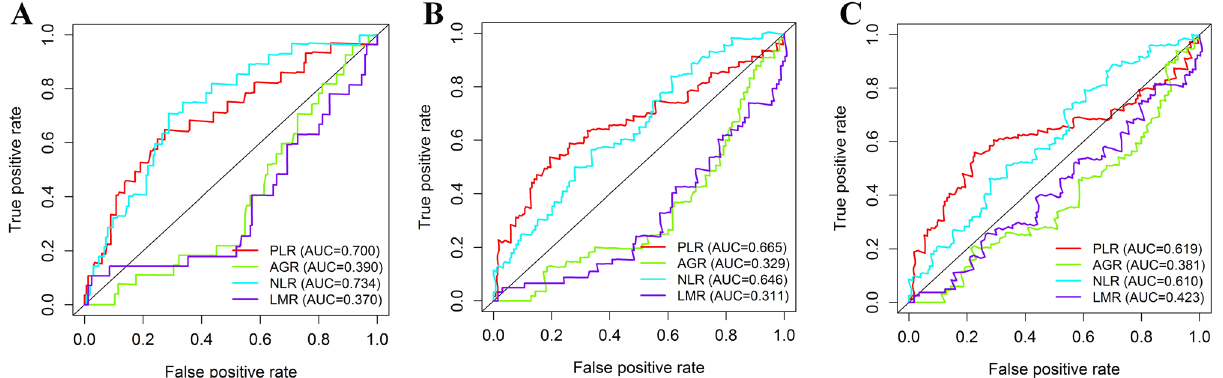
Figure 2. Comparison of the predictive ability of systemic inflammatory biomarkers in predicting 1- (A) , 3- (B) , and 5-year (C) survival. The figure was performed using R software (version 3.3.1, Vienna, Austria, https:// www.r- proje ct.